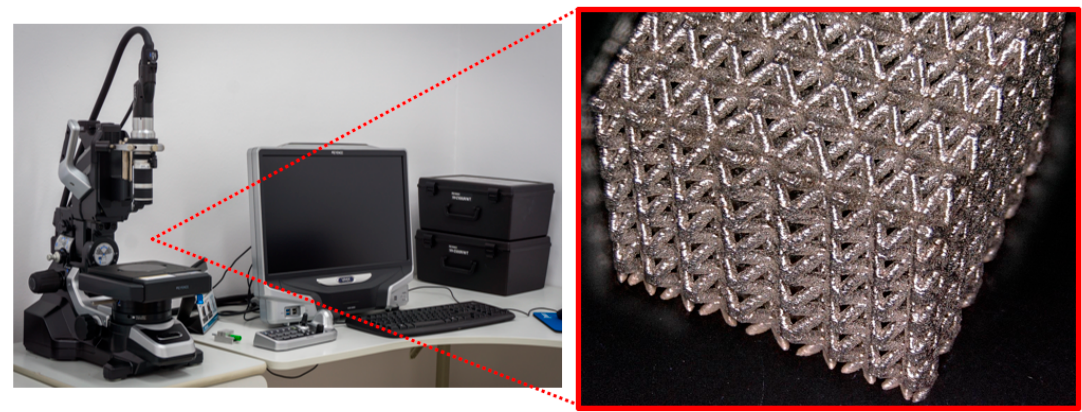
Figure 3. Digital microscope Keyence VHX-6000 (Keyence International, Osaka, Japan) used in the quality control process of manufactured structure specimens .